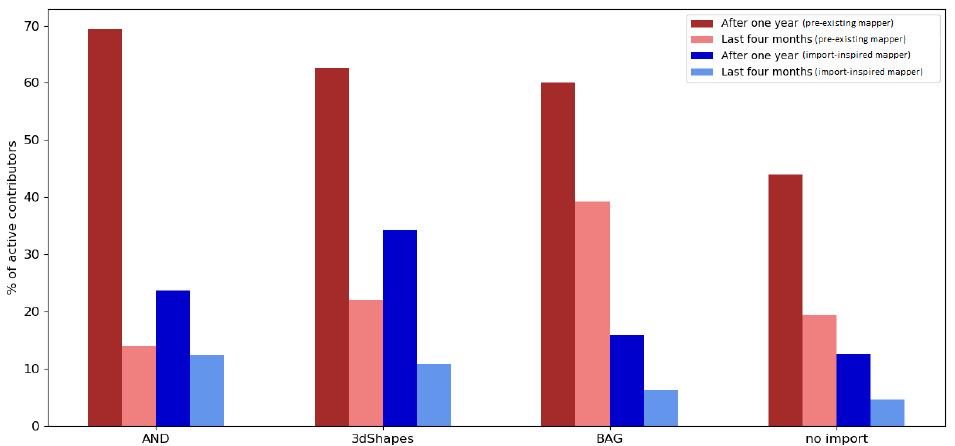
Figure 5. Ratio of contributors who participated in an import to those who remained active in the